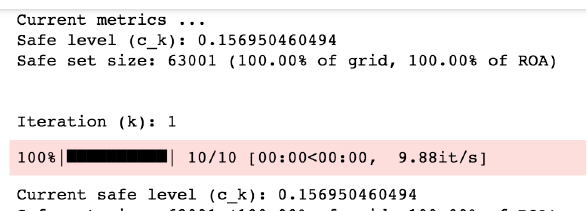
Figure 5: Initial safe level and safe set size for the GAS equilibrium.